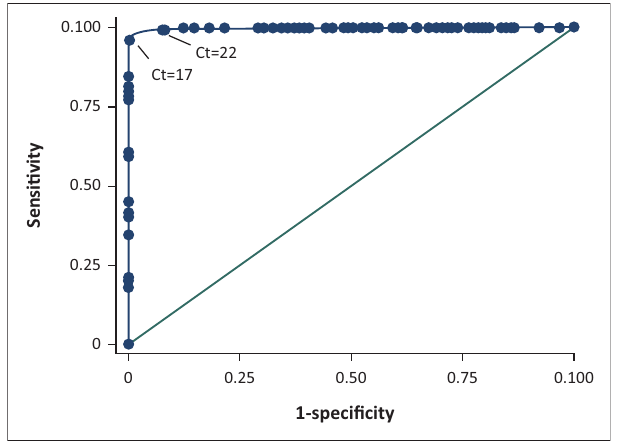
FIGURE 1-A1: Receiver operating characteristic (ROC) curve analysis was used to determine the optimal CT cut-off value for determining a positive PCR result. Samples culturing S. pneumoniae were regarded as true positives, and samples culturing organisms other than S. pneumoniae were regarded as true negatives for this analysis. ROC curve analysis suggested that the optimal CT cut-off value for determining a positive PCR result was between 17 and 22 (AUC 0.99), and the upper value of 22 was